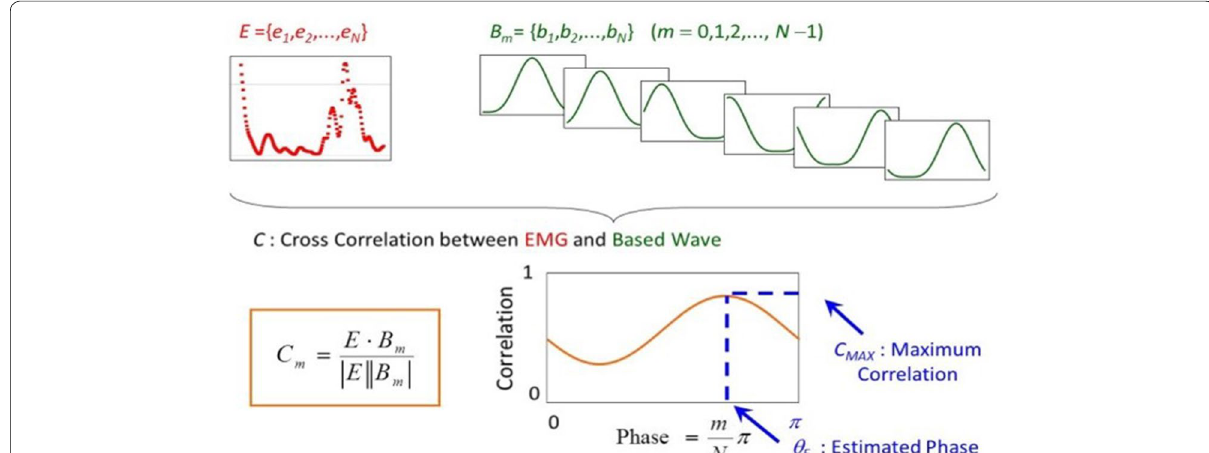
Fig. 6 Phase estimation algorithm. This algorithm searches for the maximum correlation between the base wave and the windowed EMG